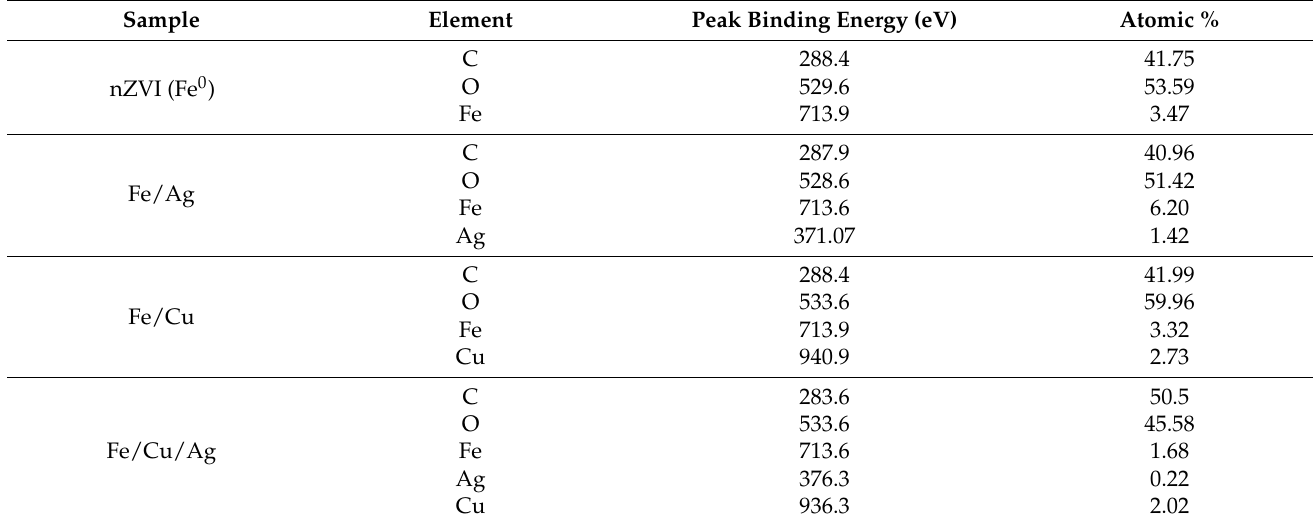
Table 1. Atomic composition extracted from the XPS of nZVI (Fe 0 ), Fe/Ag (5:0.1), Fe/Cu (5:1) and Fe/Cu/Ag (5:1:0.2) nanoparticles.